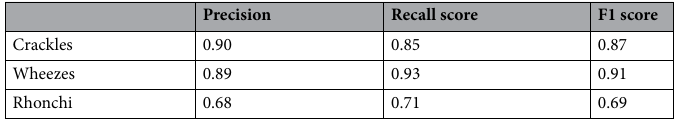
Table 4. The averages of Precision, Recall and F1 score in discriminating crackles, wheezes, and rhonchi.